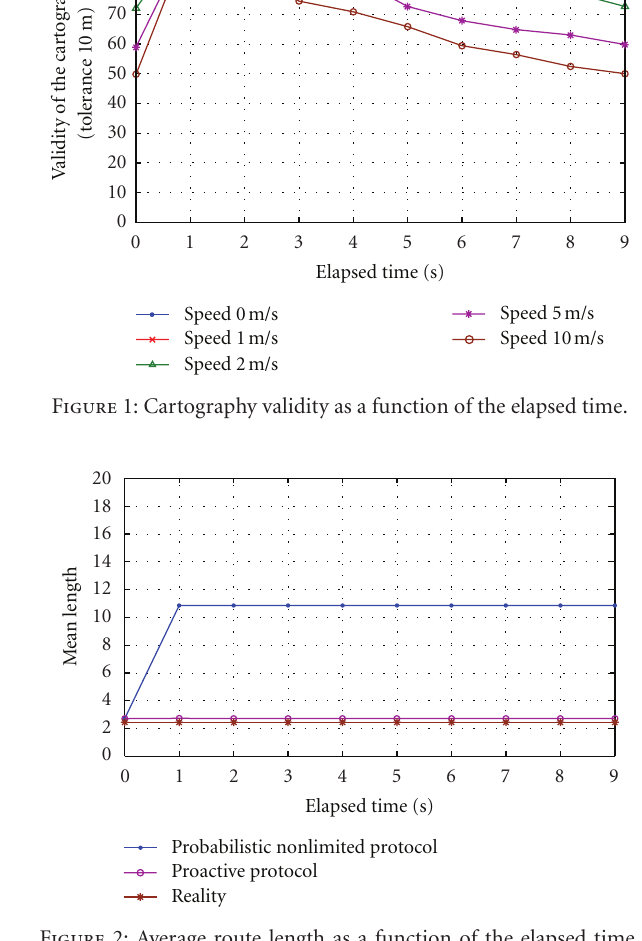
Figure 2: Average route length as a function of the elapsed time, V = 0